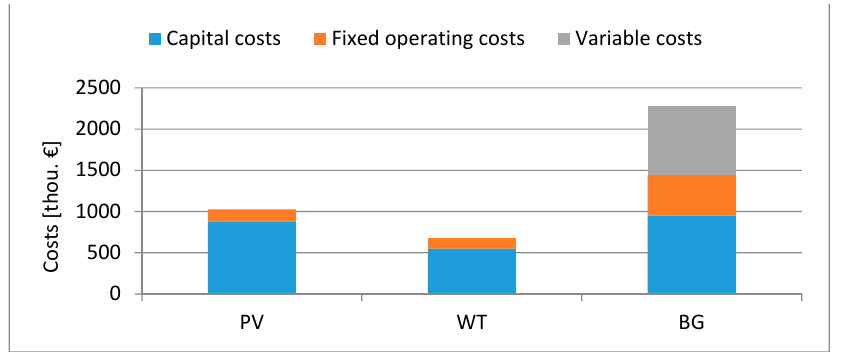
Figure 2. The cost structure for scenario “1”.